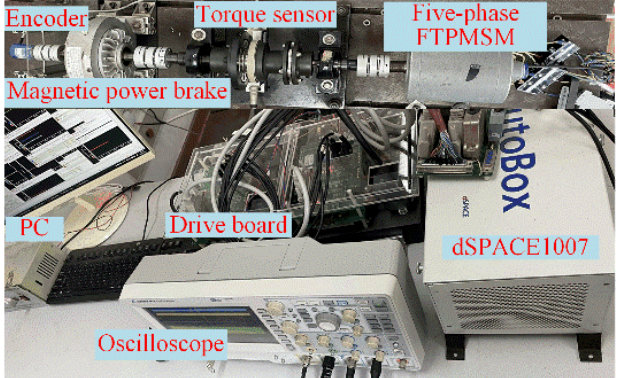
Figure 5. Experimental platform.